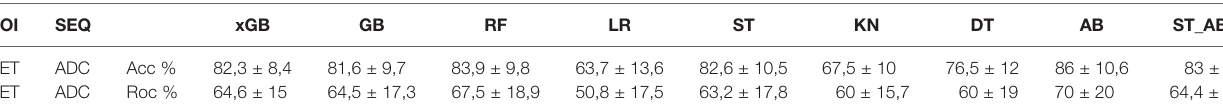
TABLE 5 | KI67 best results (reported as mean ± standard deviation).